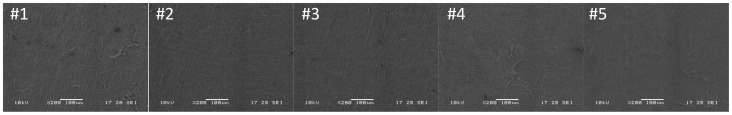
Representative SEM micrographs showing the remaining stroma after the lenitcule extraction by different instruments in the non-optimizing laser setting.The remaining stroma after the lenticule extraction remained intact, without damage caused by the instruments. Magnification 200x, scale bar: 100 µm.